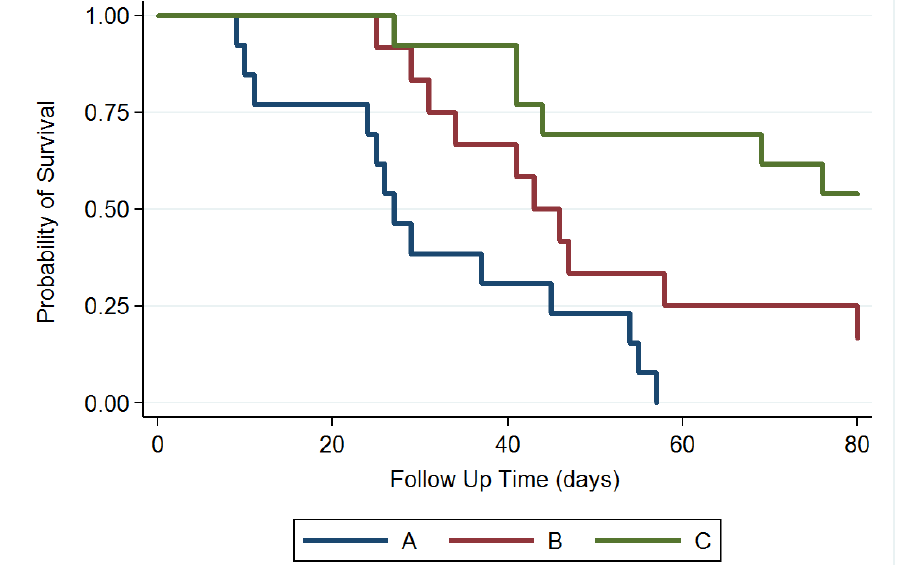
Figure 7. Survival curve. The median survival rate was significantly higher in group C than those in groups B and A; the survival rate was also higher in group B than that in group A; p = 0.028 for group B versus group A; p < 0.001 for group C versus groups B and A.